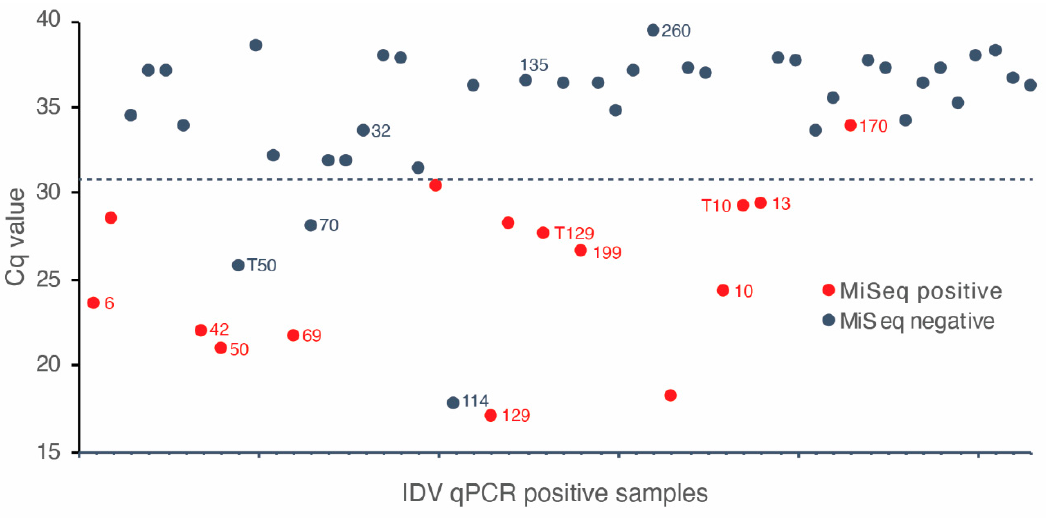
Figure 2. Cq values and MiSeq detection results for 53 samples positive by IDV qPCR. Samples positive for both qPCR and MiSeq are indicated by red dots. Most concurrent detection by MiSeq and qPCR occurred in samples with Cq values < 31 (dotted line). Samples selected for Nanopore sequencing are indicated with their respective sample identification number.